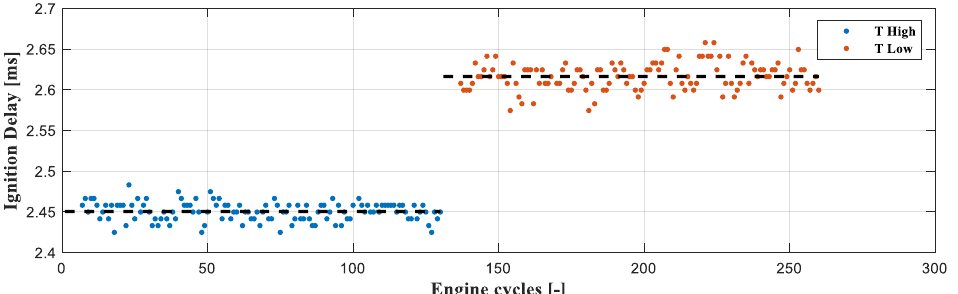
Figure 7. Effect of different intake temperatures on